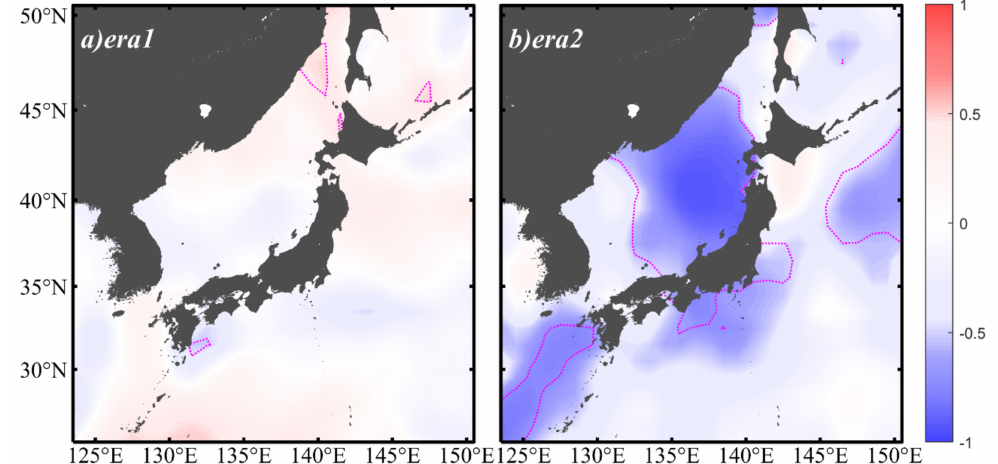
Figure 4. ( a , b ) Nonstationary spatial responses of demersal fishes to SST: maps of era-specific correlation coefficients between the shared trends and winter SST fields. Purple dotted lines enclose areas with significant correlations ( p <